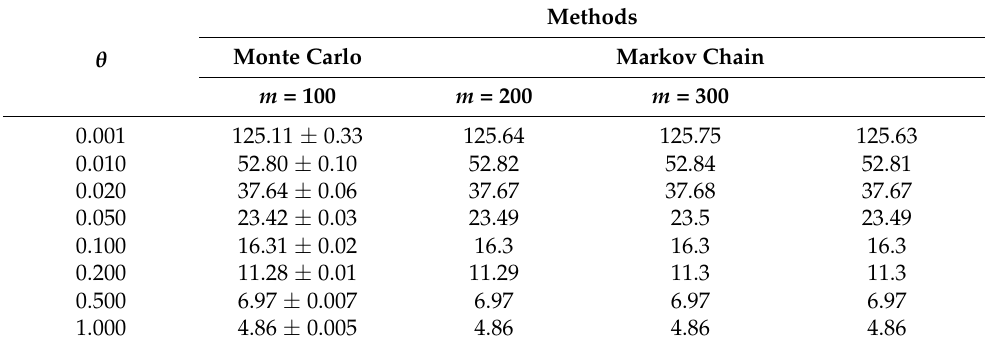
Table 2. Steady-state ARL values with different drift sizes when µ 0 = 4, λ = 0.05 and ARL 0 = 200, given τ =